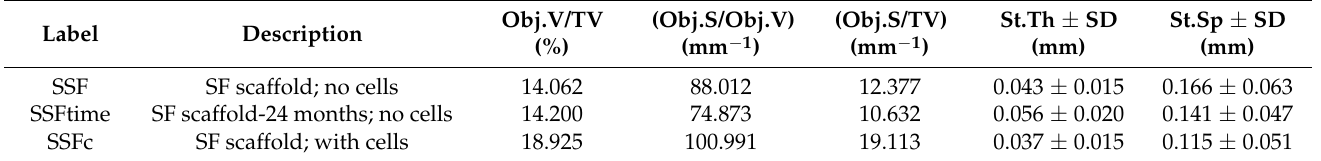
Table 1. 3D Micro-CT analysis, for the selected volume ROI: morphological parameters. Label